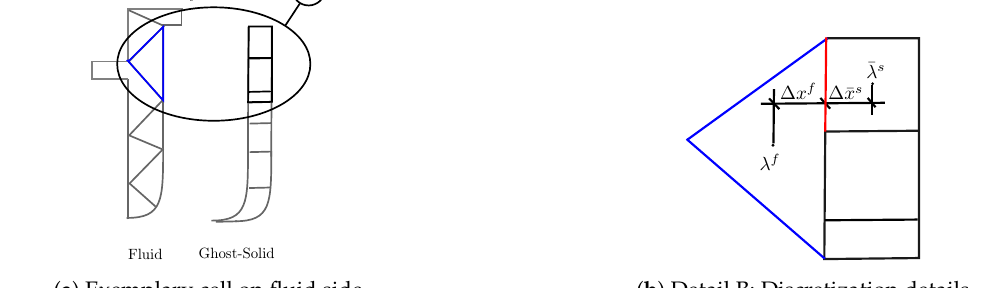
Figure 5. Implicit solid-fluid